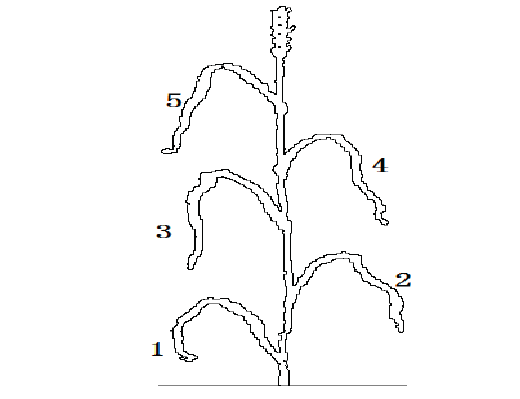
Figure 1. The illustration of the sampled wheat with leaves numerically labeled from the bottom (leaf 1) to the top (leaf 5) of the